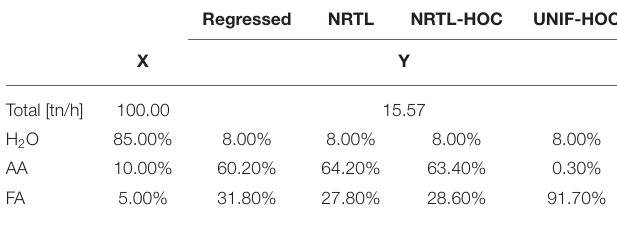
TABLE 2 | Mass balances comparison of thermodynamic models.